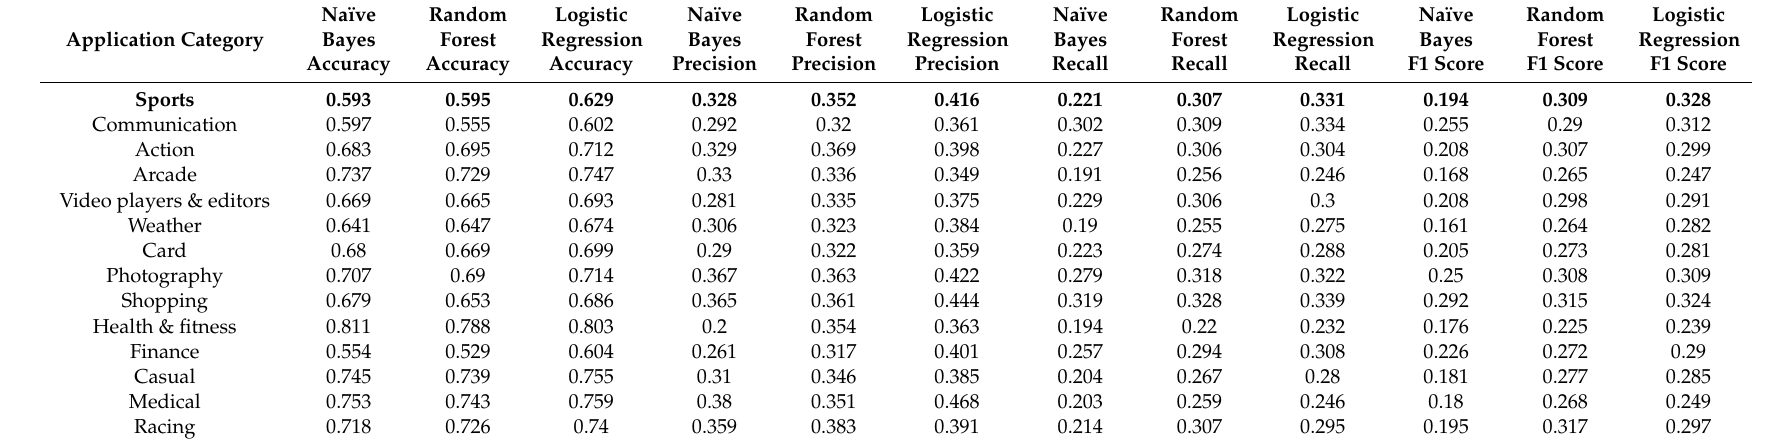
Table 5. Di ff erent machine-learning algorithm comparison on TF / IDF based without preprocessing of the